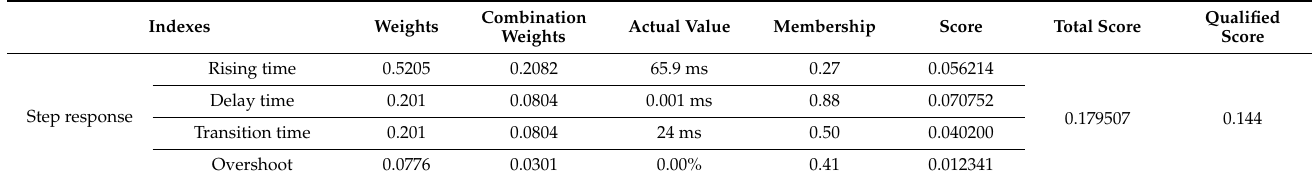
Table A4. Fuzzy PID controller torque evaluation table.